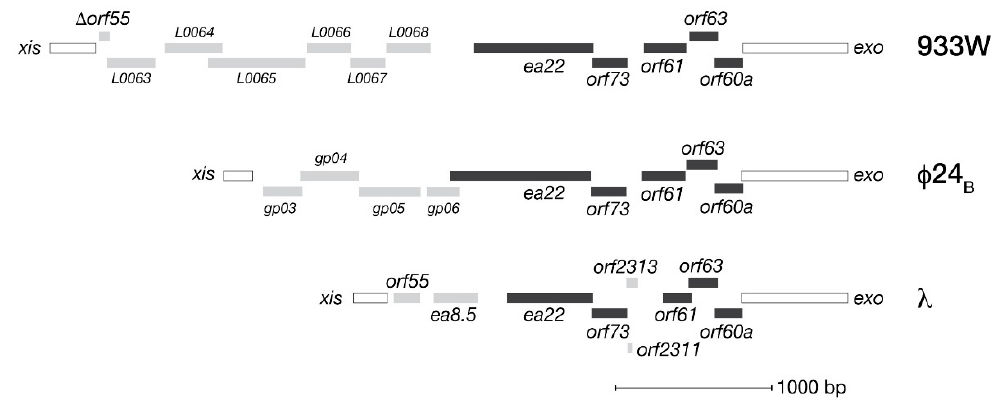
Figure 1. The exo-xis regions of λ and two Shiga toxin producing phages (933W, Ф 24 B ) associated with clinically relevant E. coli infections. Solid bars indicate a typically conserved core set of genes. Other genes are indicated by shaded bars.